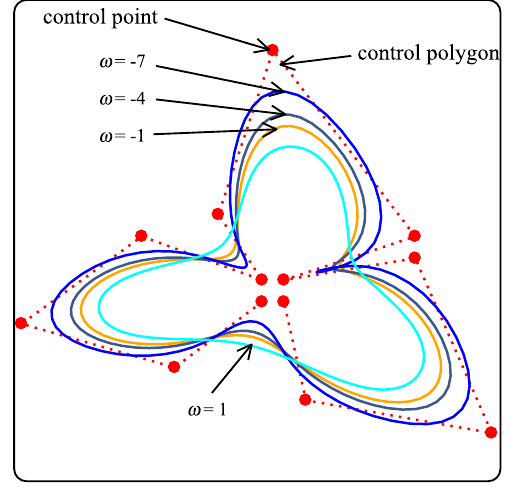
Figure 5. Parameter effects on the limit curves with initial polygon of ternary scheme.